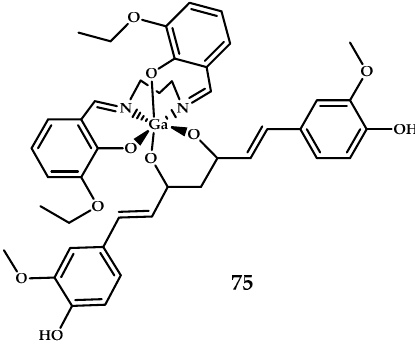
Figure 19. Curcumin–based Ga 3+ coordination compound 75 with a Schiff-based metal-chelating Figure 19. Curcumin-based Ga 3 + coordination compound 75 with a Schi ff -based metal-chelating moiety, designed for PET imaging of A β plaques. moiety, designed for PET imaging of A β